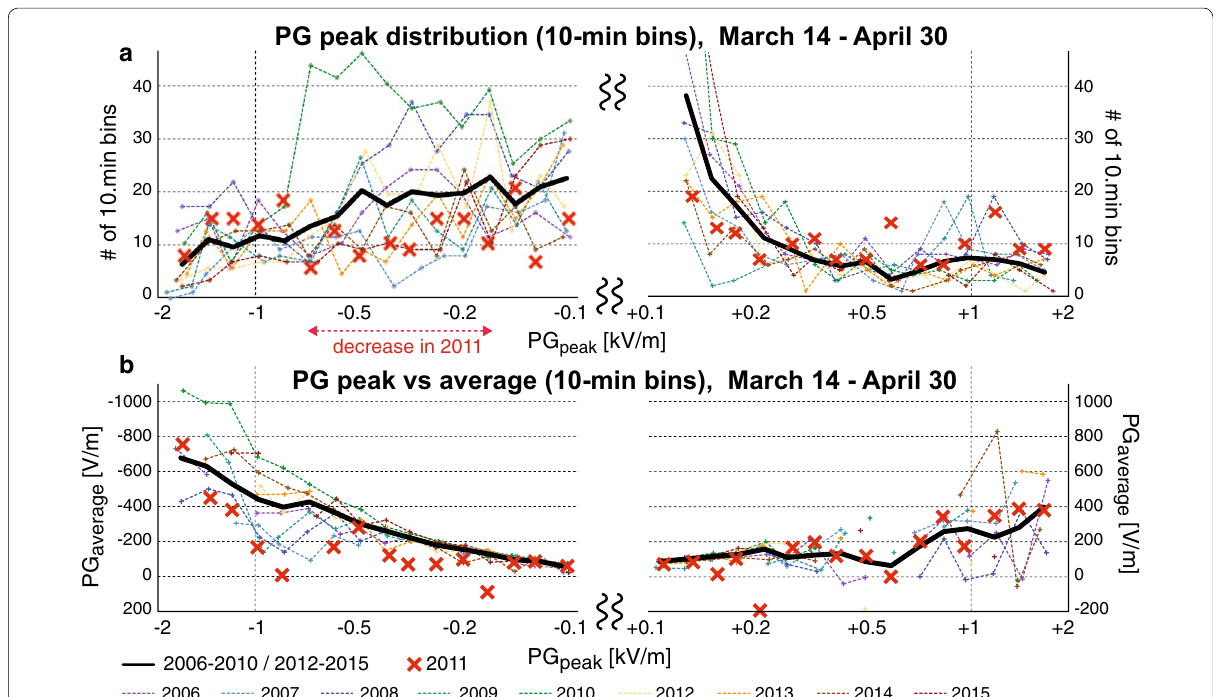
Fig. 4 a Distribution of PG peak minute values during 50 days in the same season for 2006–2015. PG peaks are registered every 10 min, and numbers of these peaks within bins that are defined in logarithmic scale (20% stepping) are plotted, such that exponential distribution becomes a constant line, b 10-min averages for each bin of PG peaks. A larger difference means quick rise and/or quick decay from the peak values. In both panels, red crosses are for 2011, dashed lines are for the other years, and thick line is for the